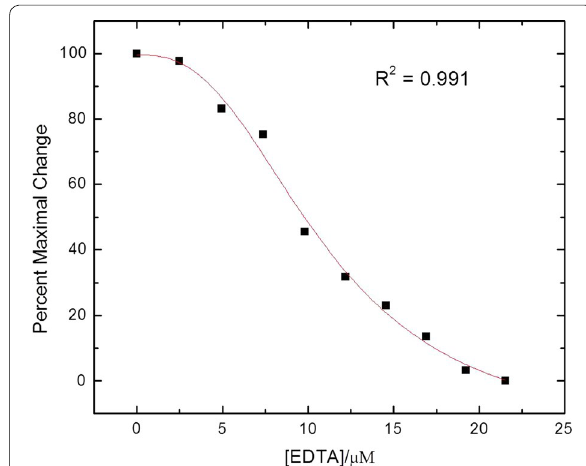
Fig. 1 EDTA titrations of ANS labeled CaM monitored by ANS fluo- rescence emission measurement. For purpose of comparison, all the fluorescence intensities were normalized to their respective 100% change. Sigmoidal fitting along with coefficient of determination ( R 2 ) were also demonstrated in Fig. 1